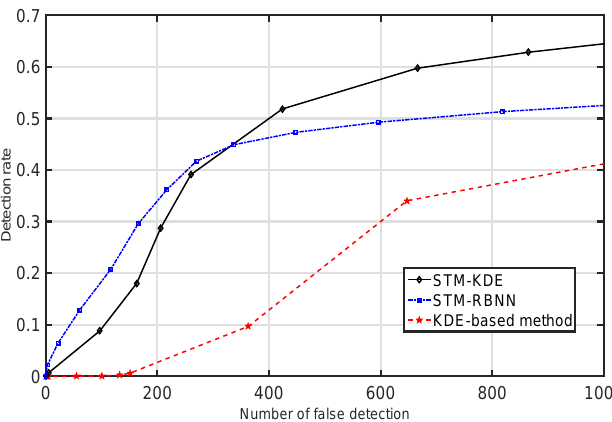
Figure 9. Receiver operating characteristic (ROC) curve in the range of 50